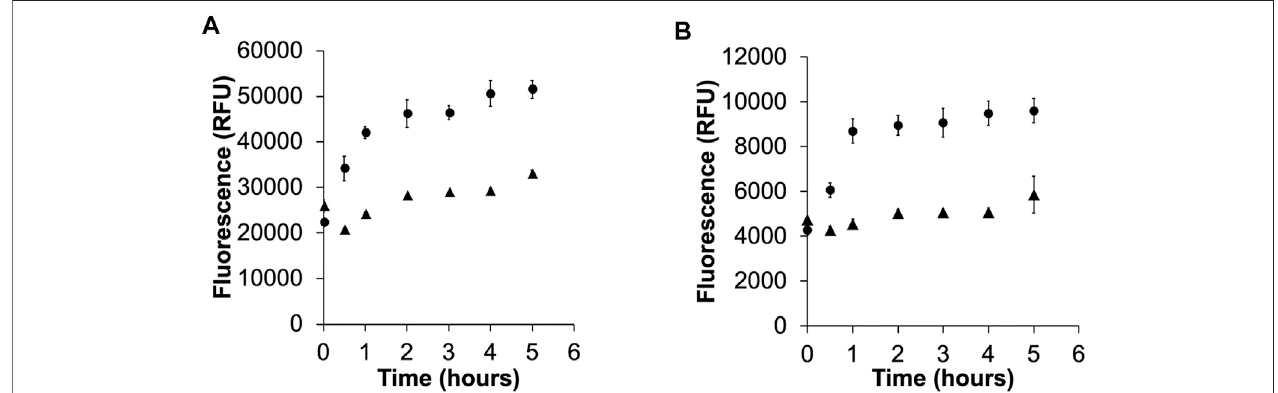
FIGURE2| Activation ofRA (A) , andMFRA (B) in 4175-Luc+(circles)and MDA-MB-231 (triangles).Thegraphsshowthe activation oftheprobesasmeasuredby the time dependent increase in fl uorescence ofthe reduced product at their respective maxima (RA red (cid:2) 585 nm, MFRA red (cid:2) 594 nm). The reduction of RAand MFRA is greater and faster in the metastatic variant 4175-Luc+ cells (Error bars (cid:2) standard deviation).